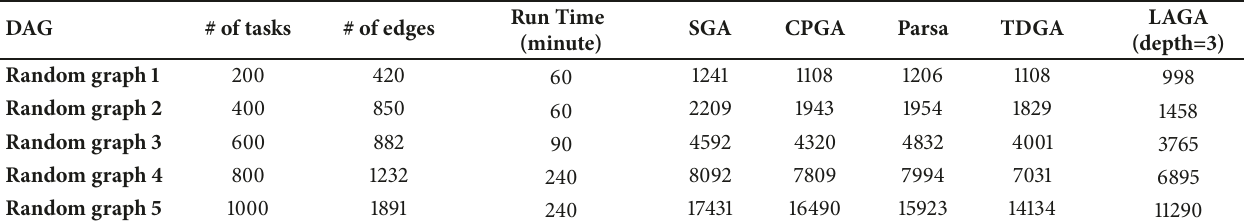
Table 9: Comparison of the three genetic-based algorithms with LAGA on four